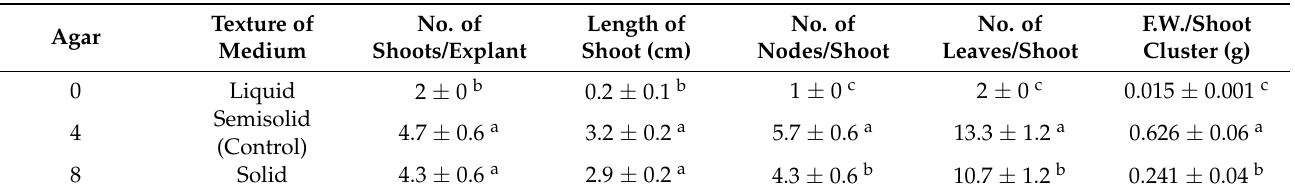
Table 3. Effect of different textures of MS medium containing 2 mg/L BAP and 0.1 mg/L NAA on shoot multiplication and growth of paulownia for one month.